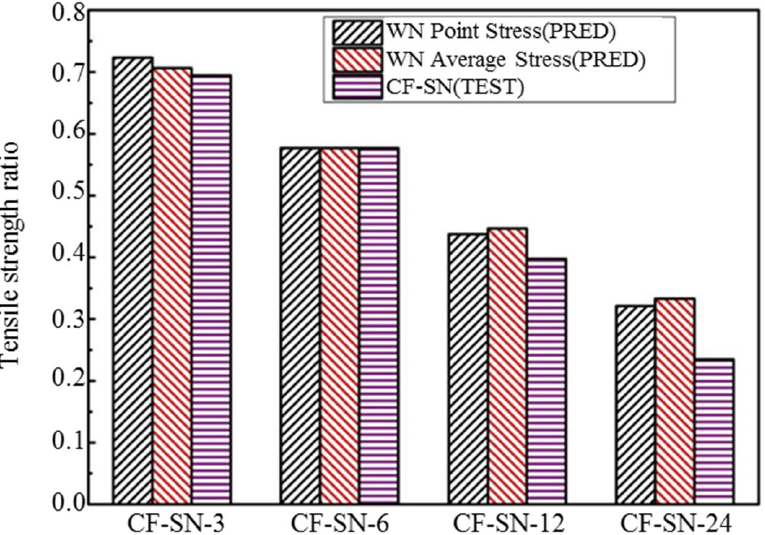
Figure 24. Comparison of the tensile strength of the equal specimen size group predicted by the point stress criterion and average stress criterion in the WN stress criteria with test results. The predicted results are not in good agreement with the experimental results when W /2 C < 6 .